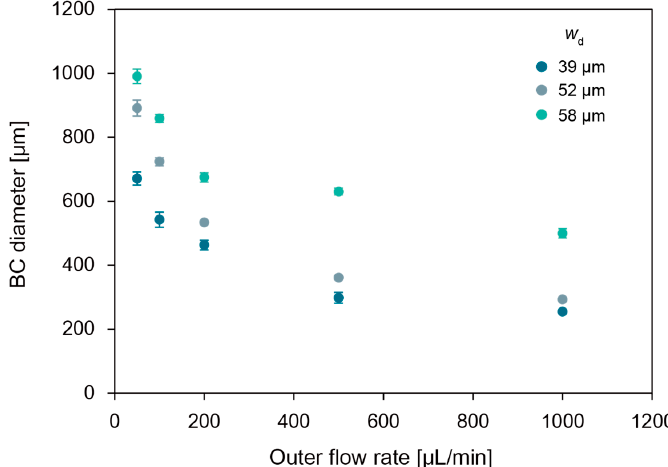
Figure 7. Diameters of BC microspheres using the emulsion prepared from the co-flow microfluidic device. Horizontal axis is the corresponding outer flow rate. Error bars represent the standard deviation; sample size n > 19.